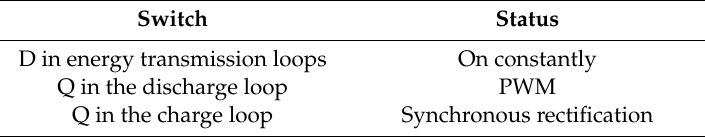
Table 1. Rules of the switching patterns. PWM: pulse width modulation.